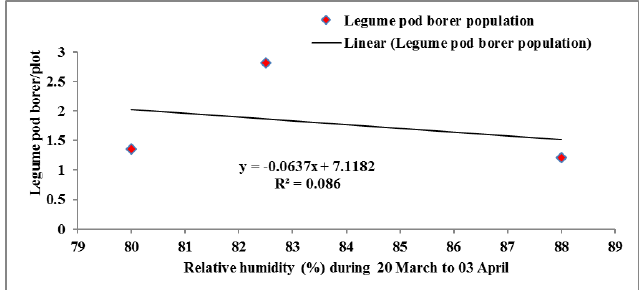
Figure 6: Relationship between the population of legume pod borer and